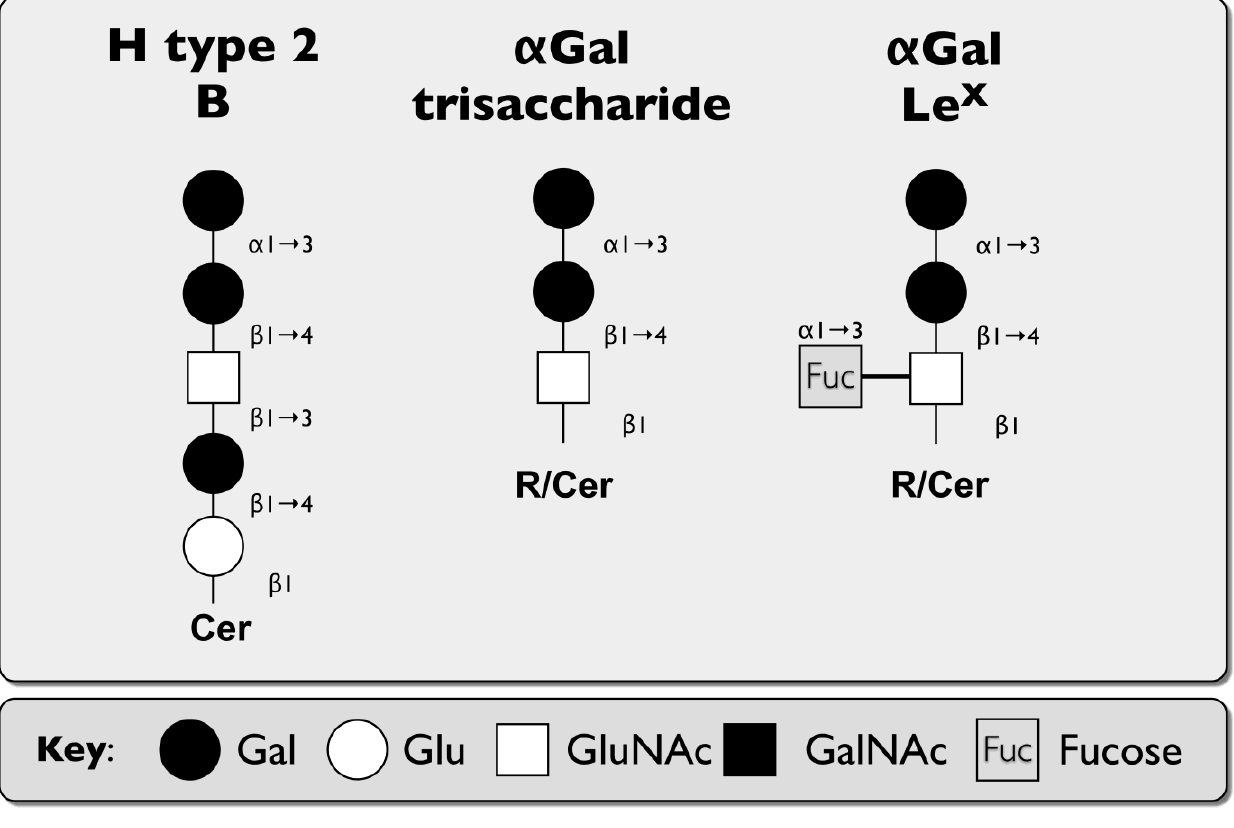
Figure 4. Comparison of discussed carbohydrate structures used during attachment of bovine NoV. Schematic representation of the BoNoV attachment receptor (  Gal and  Gal-Le X ) in comparison to the human HBGA receptor H type 2 B-antigen.